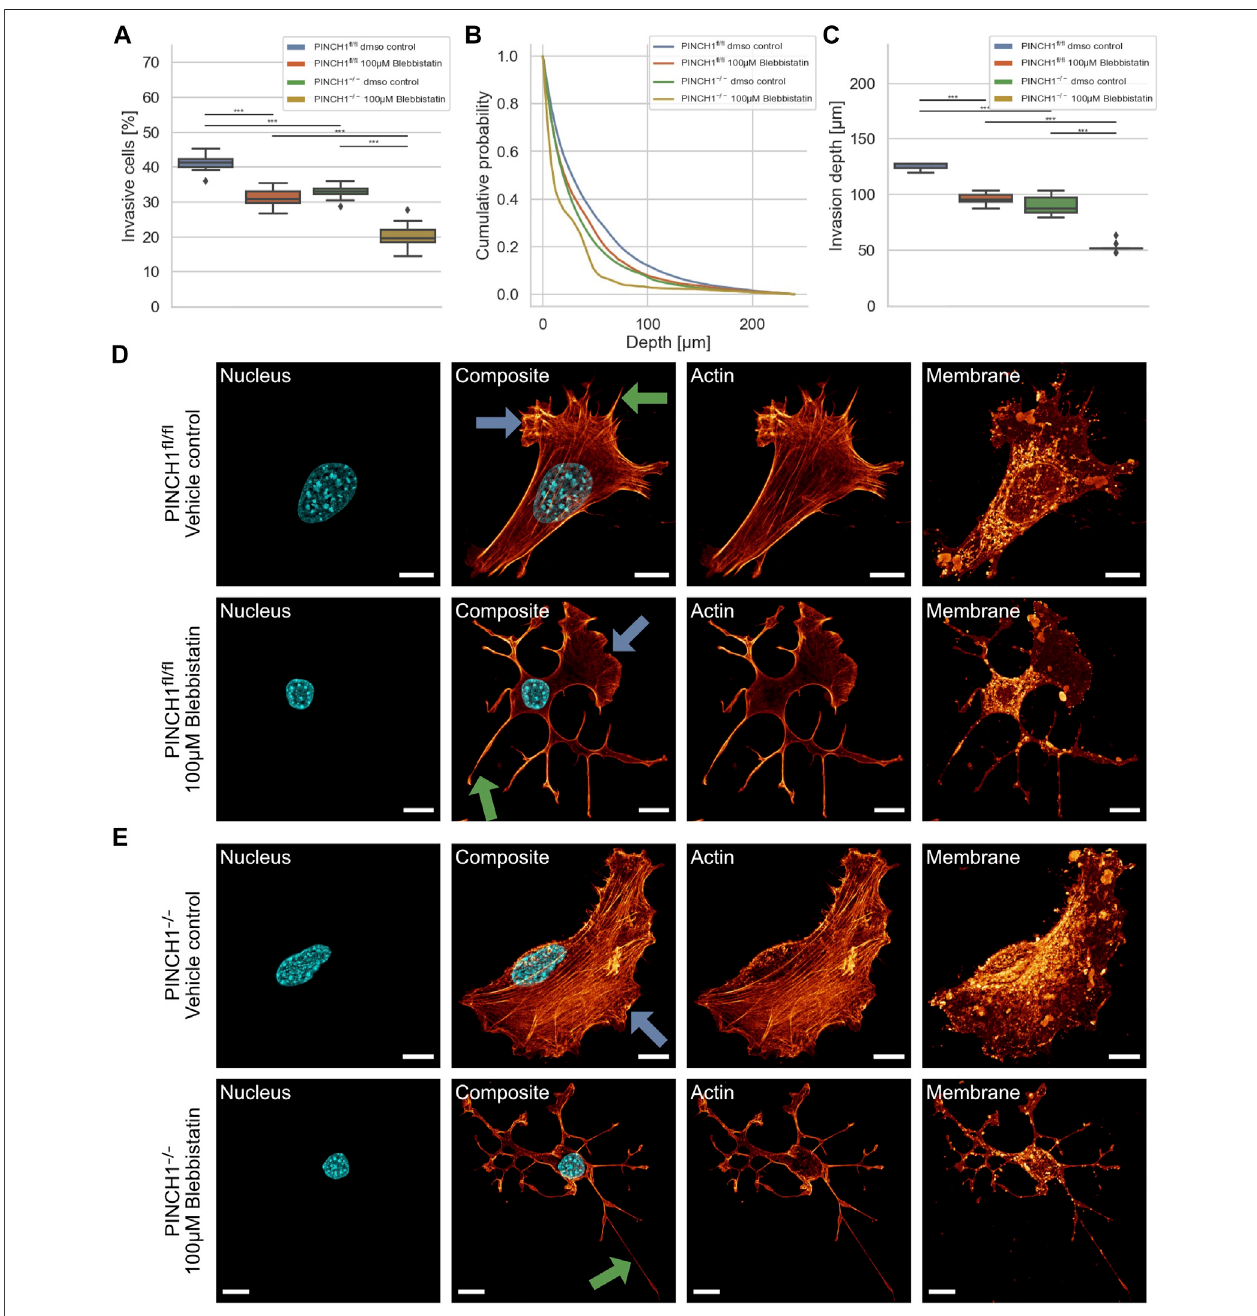
FIGURE 5 | 3D collagen invasion of PINCH1 − / − and PINCH1 fl / fl cells in the presence or absence of Blebbistatin treatment. (A) Average percentage of invasive migrating PINCH1 − / − cells (yellow, n = 52,398 cells with Blebbistatin; green, n = 1,136,648 buffer-treated control cells) is pronouncedly decreased compared to PINCH1 fl / fl cells (red, n = 200,927 cells withBlebbistatin; green, n = 591,980 buffer-treated control cells) after Blebbistatin treatment. TheBlebbistatin-treatment caused a reduction in the percentage of invasive cells compared to their buffer-treated controls. (B) Invasion depth pro fi les of the invasive PINCH1 − / − cells (green, n = 374,151cellsintheabsence, n =10,723cellsinthepresenceofBlebbistatin)andinvasivePINCH1 fl / fl cells(blue, n =243,534cellsintheabsence, n =62,641cellsinthe presence of Blebbistatin) that migrated in the 3D extracellular matrices after three days of culture at 37 ° C, 95% humidity and 5% CO 2 in the presence and absence of Blebbistatin. (C) The invasion depth of Blebbistatin-treated PINCH1 − / − cells is most pronouncedly impaired compared to blebbistatin-PINCH1 fl / fl cells. Moreover, the average invasion depth of PINCH1 − / − cells (green column) is pronouncedly lower compared to PINCH1 fl / fl cells (blue column) either in the presence or absence of Blebbistatin. (A,C) data are presented as box and whiskers plots (Q2 represent mean values). (D,E) Confocal laser scanning images are presented as maximal projections. Inhibition of actin polymerization by Blebbistatin alters the morphology and the actin cytoskeleton of PINCH1 fl / fl cells (D) and PINCH1 − / − cells (E) using a confocal laser scanning microscopy. Cells were cultured on planar substrates coated with 10 μ g/ml laminin and treated for 2 h with Blebbistatin (100 μ M). After fi xation,